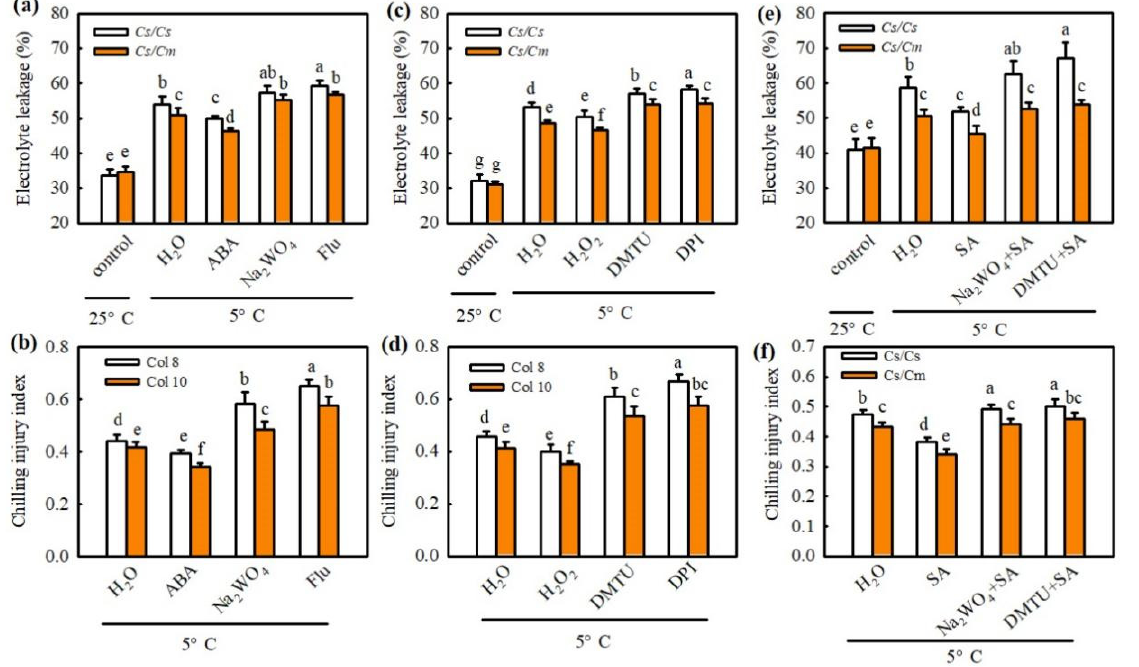
Figure 5. The role of ABA and H 2 O 2 in SA- or grafting-induced chilling tolerance in cucumber. ( a ) Electrolyte leakage of plants after chilling treatment for 0 h and 48 h. ( b ) Chilling injury index of plants after chilling treatment for 0 h and 72 h. Plants were foliar sprayed with 50 µ M ABA, 3 mM Na 2 WO 4 , 50 µ M fluridone, or distilled water (control) for 12 h and then exposed to chilling stress. ( c ) Electrolyte leakage of plants after chilling treatment for 0 h and 48 h. ( d ) Chilling injury index of plants after chilling treatment for 0 h and 72 h. Plants were foliar sprayed with 1 mM H 2 O 2 , 5 mM DMTU, 0.1 mM DPI, or distilled water (control) for 12 h and then exposed to chilling stress. ( e ) Electrolyte leakage of plants after chilling treatment for 0 h and 48 h or 72 h, respectively. ( f ) Chilling injury index of plants after chilling treatment for 0 h and 72 h. Plants were pretreated with 1 mM SA, 3 mM Na 2 WO 4 + 1 mM SA, 5 mM DMTU + 1 mM SA, or distilled water (control) for 12 h and then exposed to chilling stress. Data are presented as the means ± SD ( n = 3). Different letters indicate a statistical significance between samples at p < 0.05.